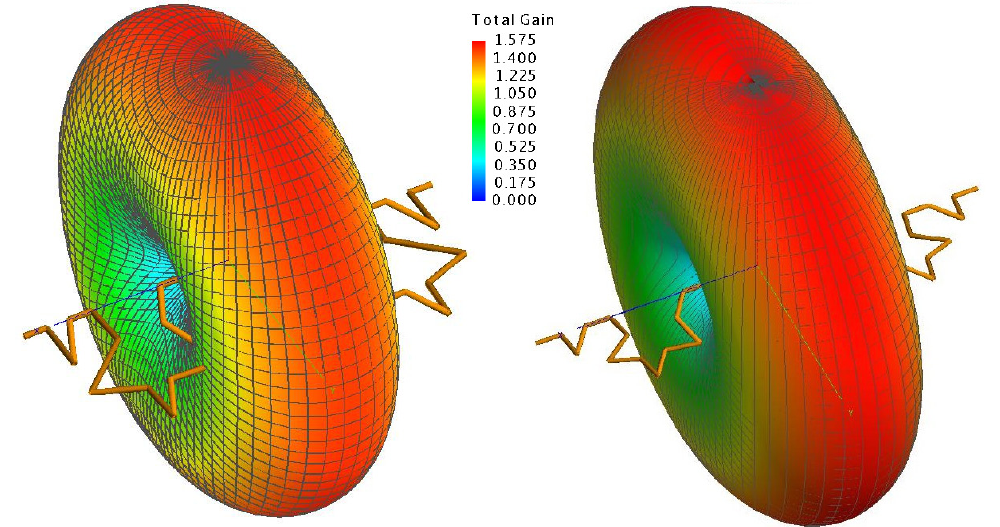
Figure 10. Radiation patterns of the obtained antennas at frequency equal to 2430 MHz. Left picture: gain for the antenna with radius equal to 14.1 mm. Right picture: gain for the antenna with radius equal to 20 mm.